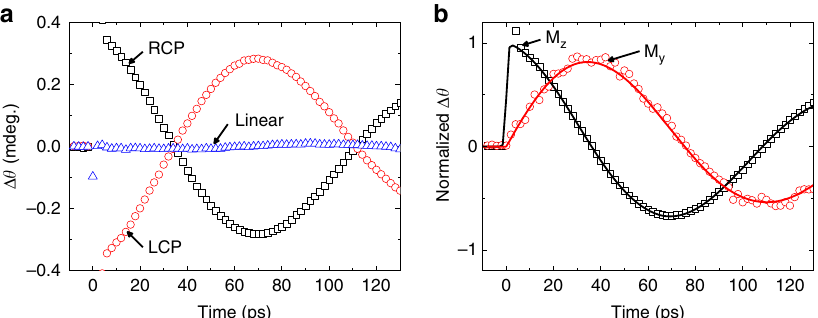
Fig. 2 Optical spin – orbit torque. a The measured dynamics of the z -component of Co magnetization in the sap/Pt(5)/Co(3)/MgO(3) sample driven by pump pulse, incident on the substrate side, with right circular polarization (RCP) (black squares), left circular polarization (LCP) (red circles), and linear polarization (blue triangles). Given the negative value of the static Kerr rotation of Co (Supplementary Note 6), positive/negative Δ θ of a indicates – z / + z tilting of magnetization. b The comparison of the M z (black squares) and M y (red circles) dynamics of Co in the sap/Pt(5)/Co(3)/MgO(3) sample. The black and red lines are fi tting with cosine and sine functions, respectively.